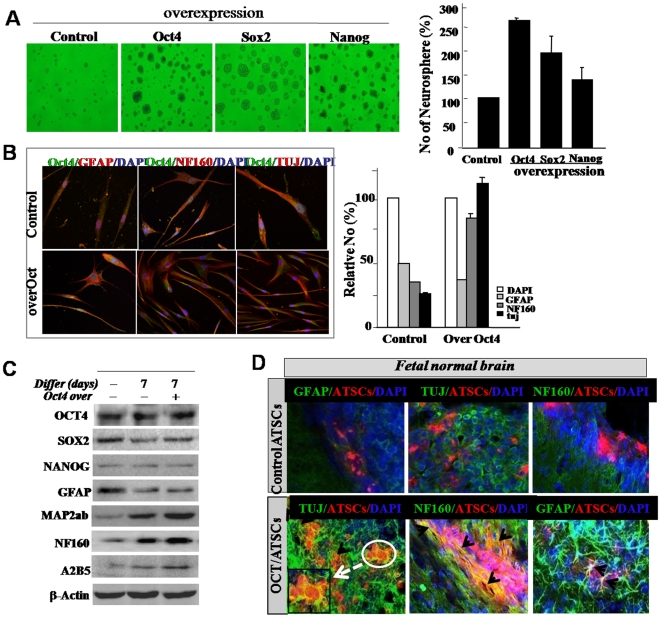
The transdifferentiation potency of Oct4/ATSCs to a neural lineage in vitro and in vivo.(A) Overexpression of several stemness genes enhances increased neurosphere formation. Neurospheres were counted after genes transfected ATSCs suspended in NB media culture and compared to the number of neurospheres derived from control and stemness overexpressed ATSCs. (B) Comparison of neural differentiation efficiency after neural differentiation induction between control ATSCs and Oct4/ATSCs. After neural differentiation, differentiation efficiency was evaluated by immunocytochemistry using anti-Tuj, anti-NF160, and anti-GFAP antibody and fluorescence-tagged secondary antibodies and we also analyzed stemness genes and neural specific gene expression pattern through (C) western blotting analysis. (D) Evaluation of in vivo integration and neurogenesis of engrafted Oct4/ATSCs in postnatal mouse brain using the immunohistochemistry method. Arrows indicate differentiated Oct4/ATSCs into MAP2ab-positive neurons.